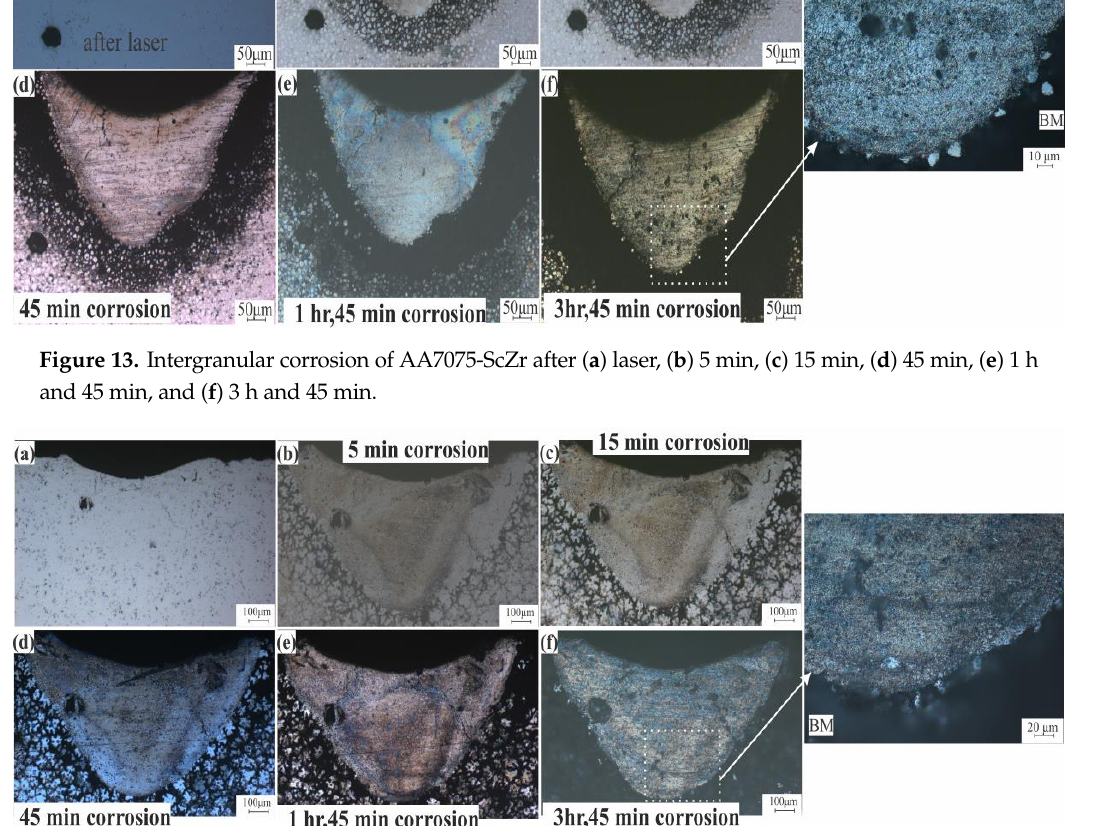
Figure 14. Intergranular corrosion of AA7075-TiB ( a ) laser, ( b ) 5 min, ( c ) 15 min, ( d ) 45 min, ( e ) 1 h and 45 min, and ( f ) 3 h and 45 min.